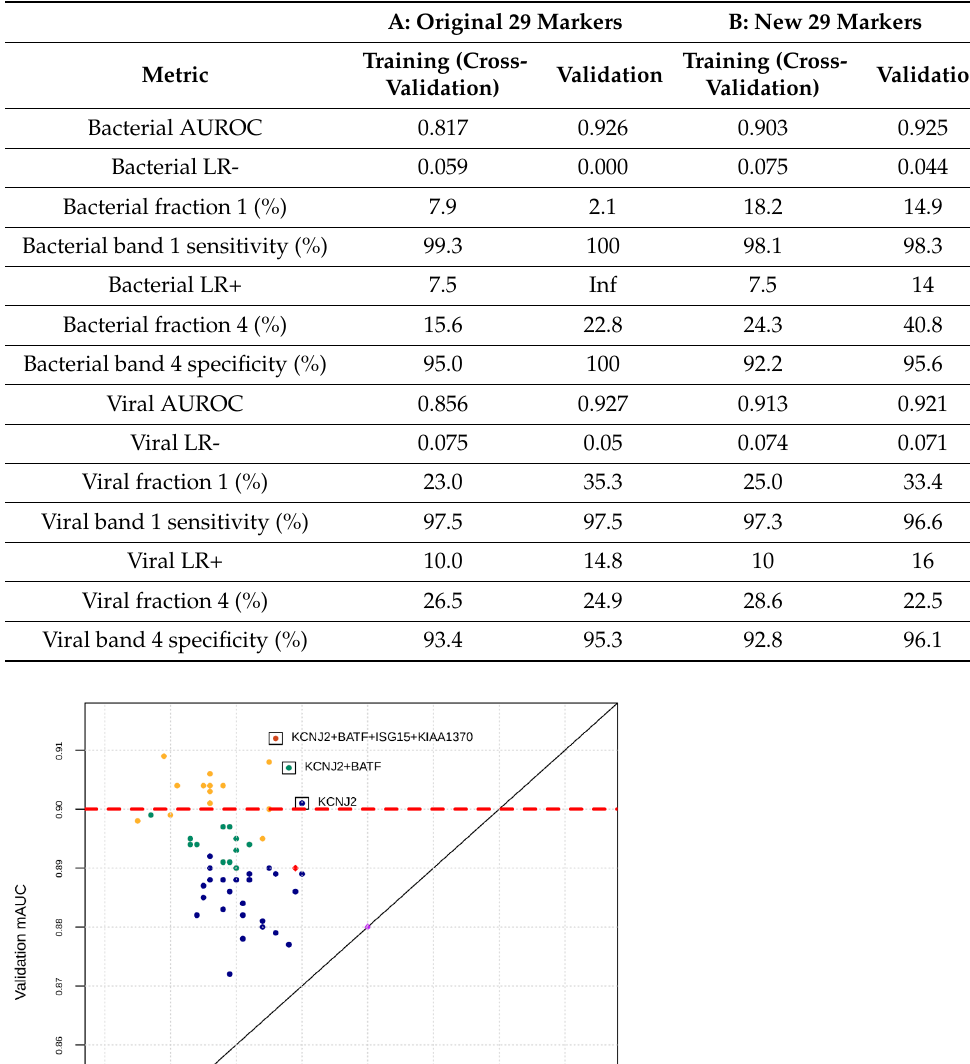
Table 4. Clinical diagnostic performance metrics for the 29 original markers (A) and the 29 final markers (B). The classifier used for original 29 markers was Support Vector Machine (SVM) with non-linear (RBF) kernel. The classifier used for new 29 markers was an assemble of multi-layer perceptron neural networks. The classifiers were selected on the basis of the best trade-off between mAUROC in training data (cross-validation) and validation.